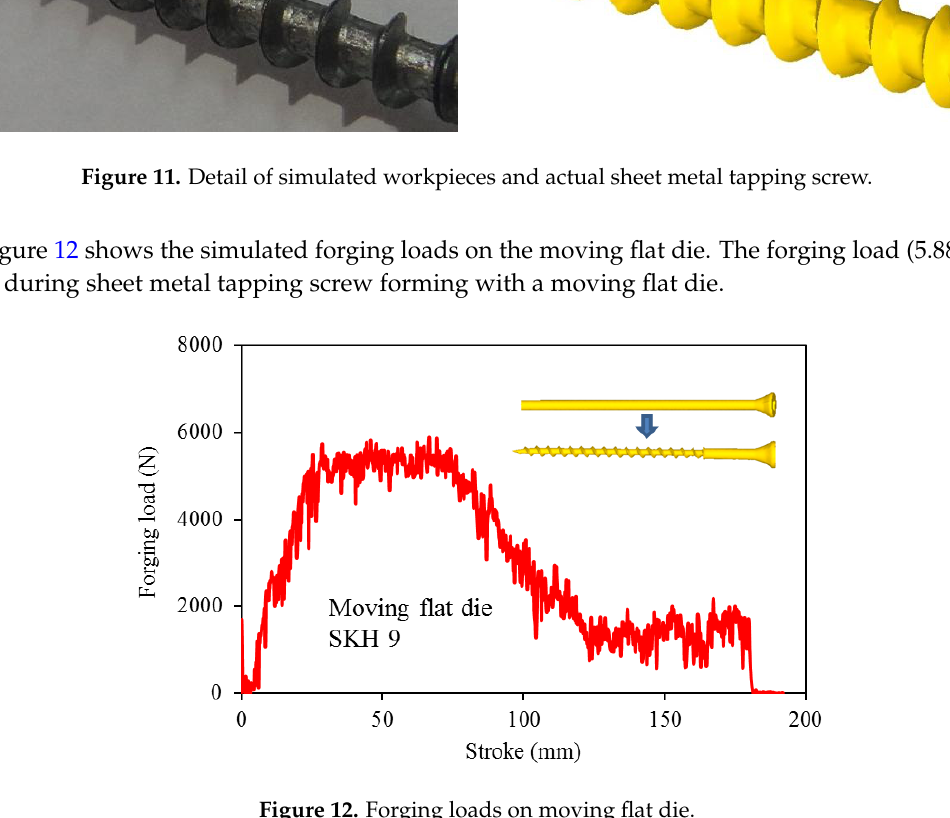
Figure 12. Forging loads on moving flat die.